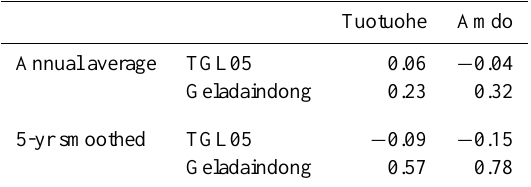
Table 3. Correlations between δ 18 O values and average JJAS sta- tion temperatures for annual and 5-yr running means in the TGL05 ice core, and for the Geladaindong ice core (Kang et al., 2007). Re- ported values are from 1966–2003 for Amdo station, 1958–2003 for Tuotuohe station.